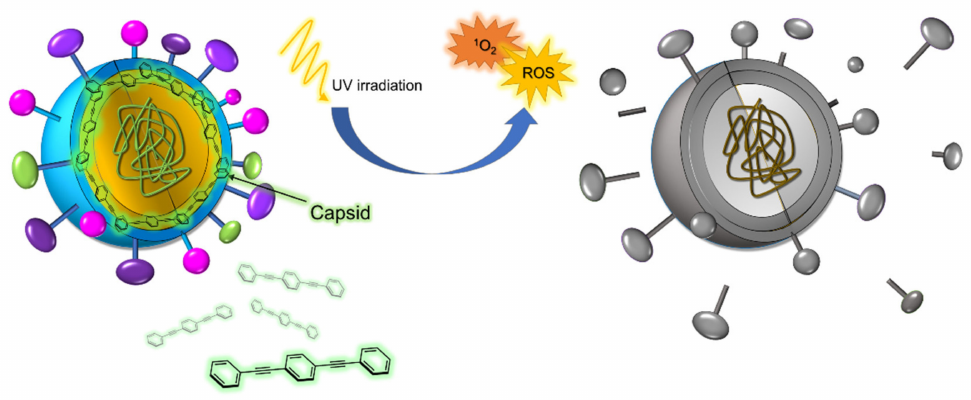
Figure 12. Illustrative image of viral attack by some OPE